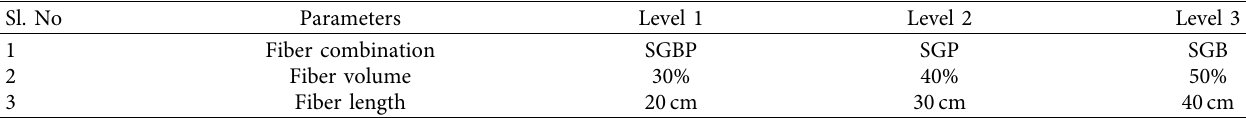
Table 4: Input parameters.